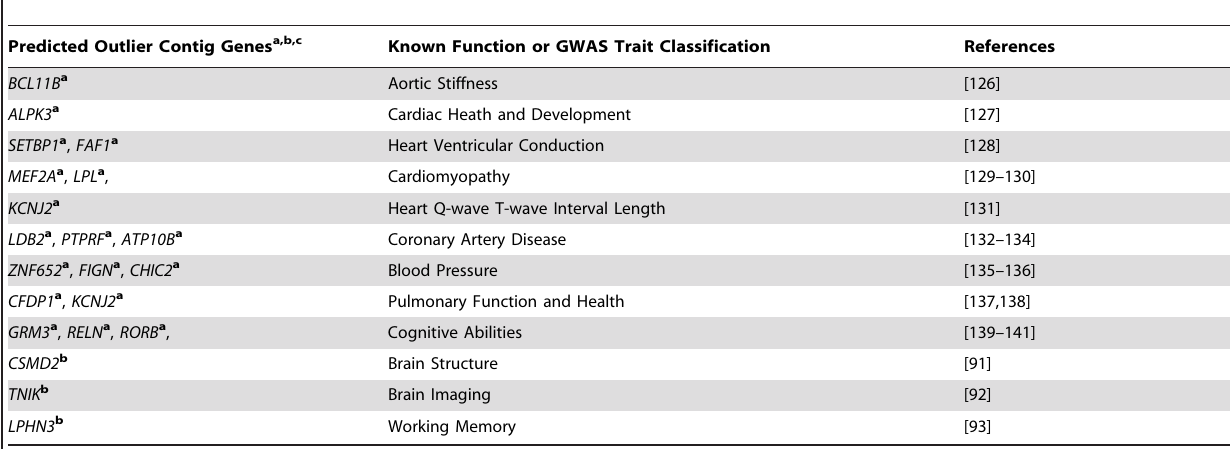
Table 4. Biologically relevant bobwhite NB1.0 simple de novo outliers from a genome-wide analysis of divergence with the chicken genome ( G. gallus 4.0).